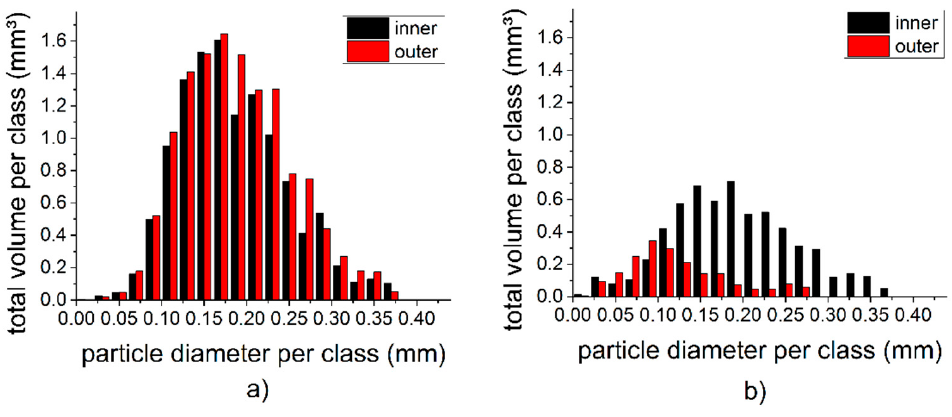
Figure 6. Size distributions of the zinc particles in the discharged RAM cell. ( a ) Pristine and ( b ) after the 10th cycle (discharge current 200 mA).